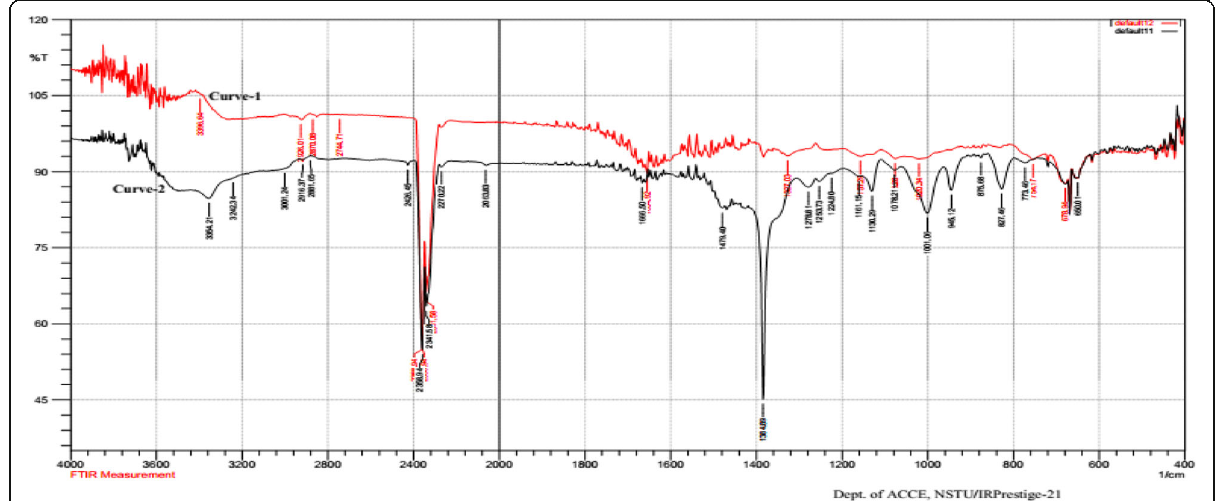
Fig. 2 FTIR spectrum of M. charantia extract (Curve-1) and Ag-Extract-NPs